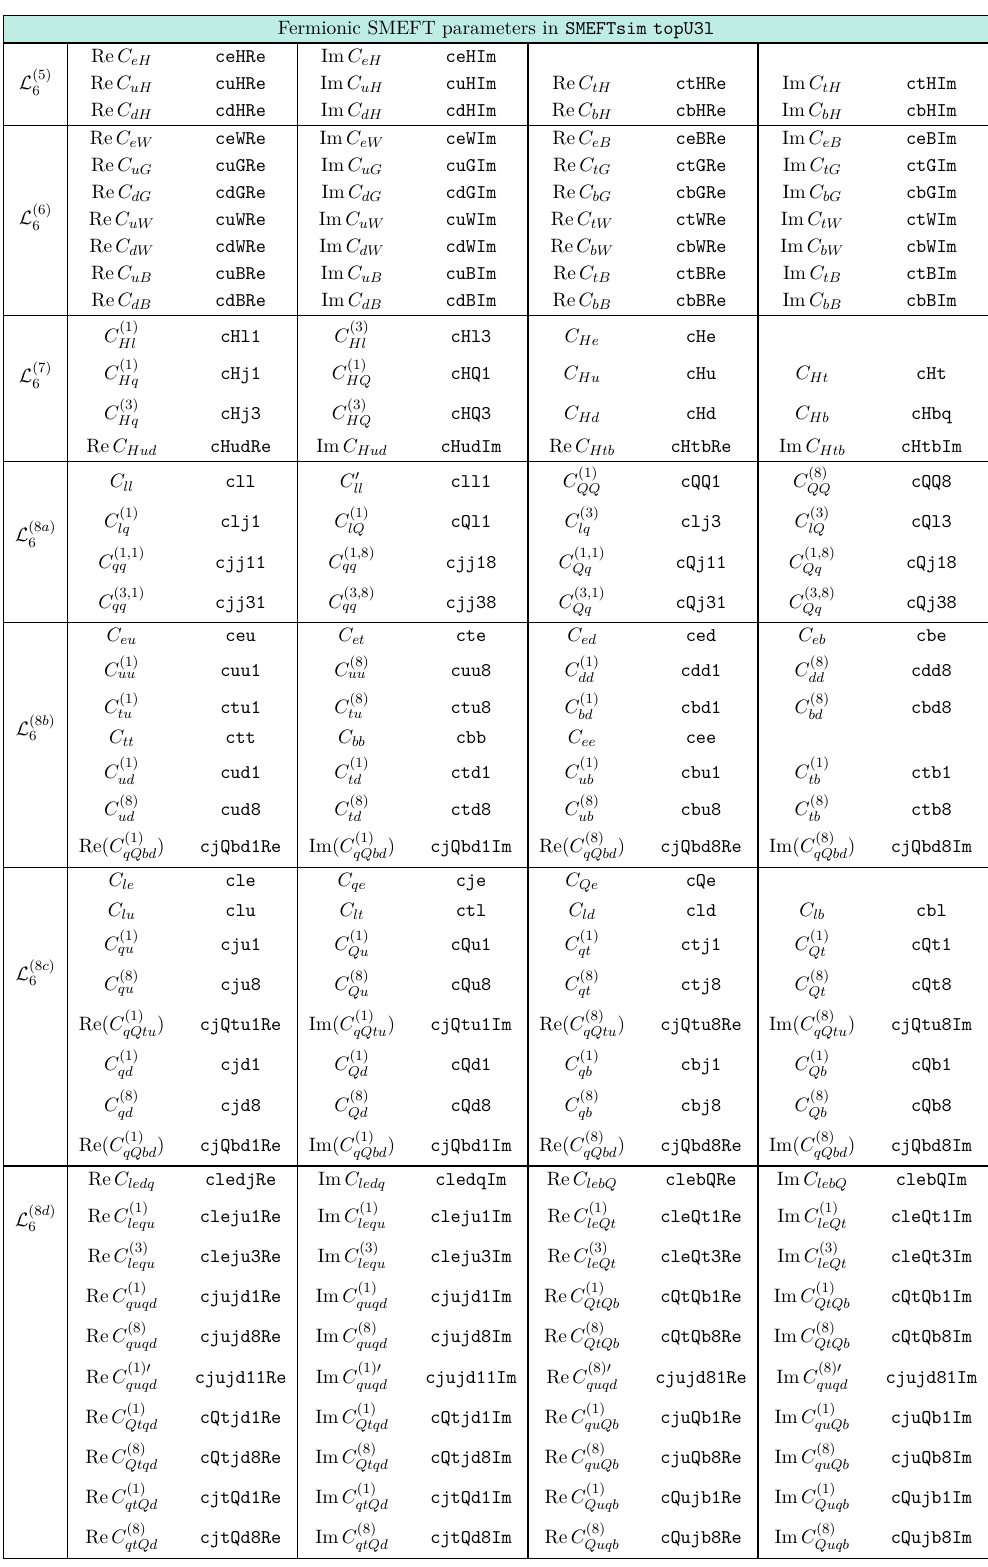
defined in the topU3l model, see section 6